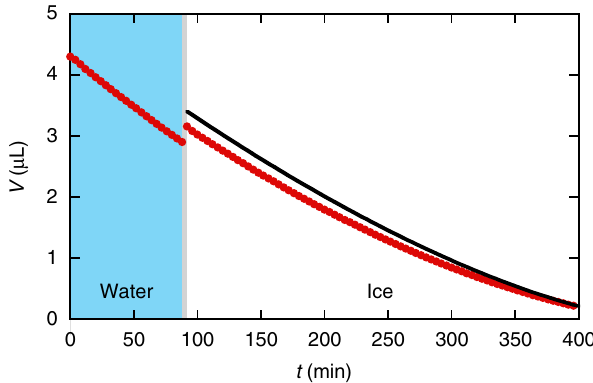
Fig. 3 Water vs. ice evaporation. Volume as a function of time for a water drop evaporating on a cold plate ( T s = − 15 °C, RH = 2.8%). The drop is initially supercooled (blue background) and freezes after 92 min (white background, see Supplementary Movie 3). Red symbols are experimental results, the black curve is the result of the analytical model (see Supplementary Note 2)